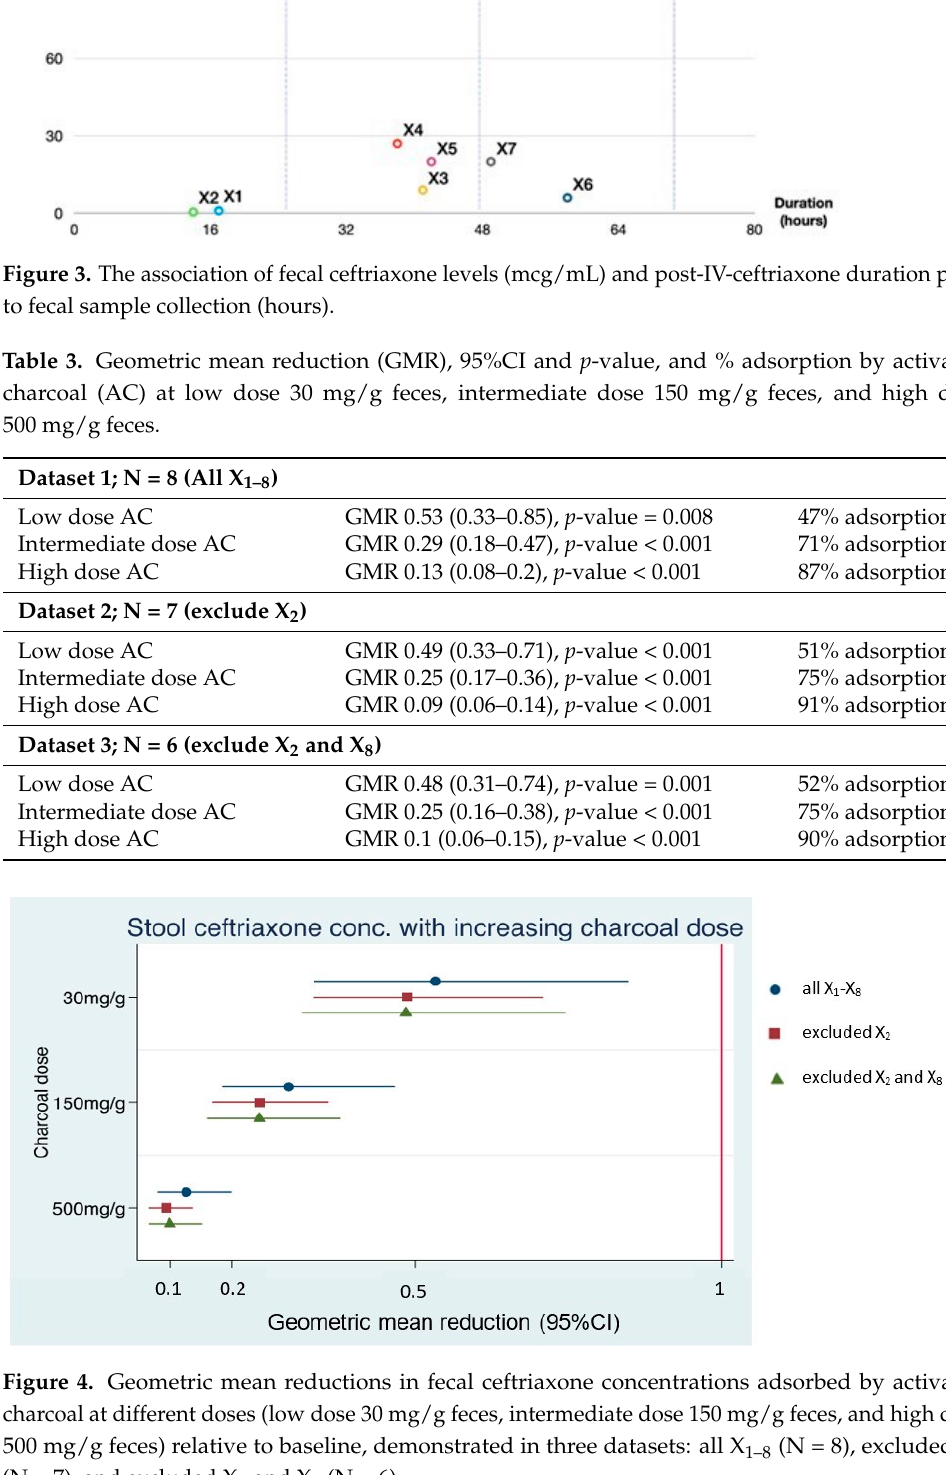
Figure 5. Graph showing decreasing median (IQR) ceftriaxone concentrations (mcg/mL) with in- creasing activated charcoal doses added; dataset 1 (N = 8, all X 1–8 ). Note: y -axis is on a logarithmic scale. 4. Discussion Activated charcoal (AC) has a high surface area, which facilitates the adsorption of toxic substances; it is commonly used for gastric decontamination. Furthermore, conven- tional oral AC is also used for supportive care in food poisoning without documented clinical benefit. DAV132, an engineered AC, which functions only in the human colon, could adsorb moxifloxacin that was secreted to the bowel without interfering with plasma drug levels [19]. This suggests that AC may be able to protect the gut microbiota against unavoidable collateral damage from systemic antibiotic use. Our study is the first preliminary in vitro study demonstrating the efficacy of con- ventional oral AC, an inexpensive drug, to adsorb excess fecal ceftriaxone. We found that the daily recommended dose of 3 g per day of commercially available oral AC was effec- tive in adsorbing excess ceftriaxone in feces. Prescribing conventional oral AC together with IV ceftriaxone simultaneously might adsorb excess fecal ceftriaxone and alleviate in- testinal microbiota dysbiosis.